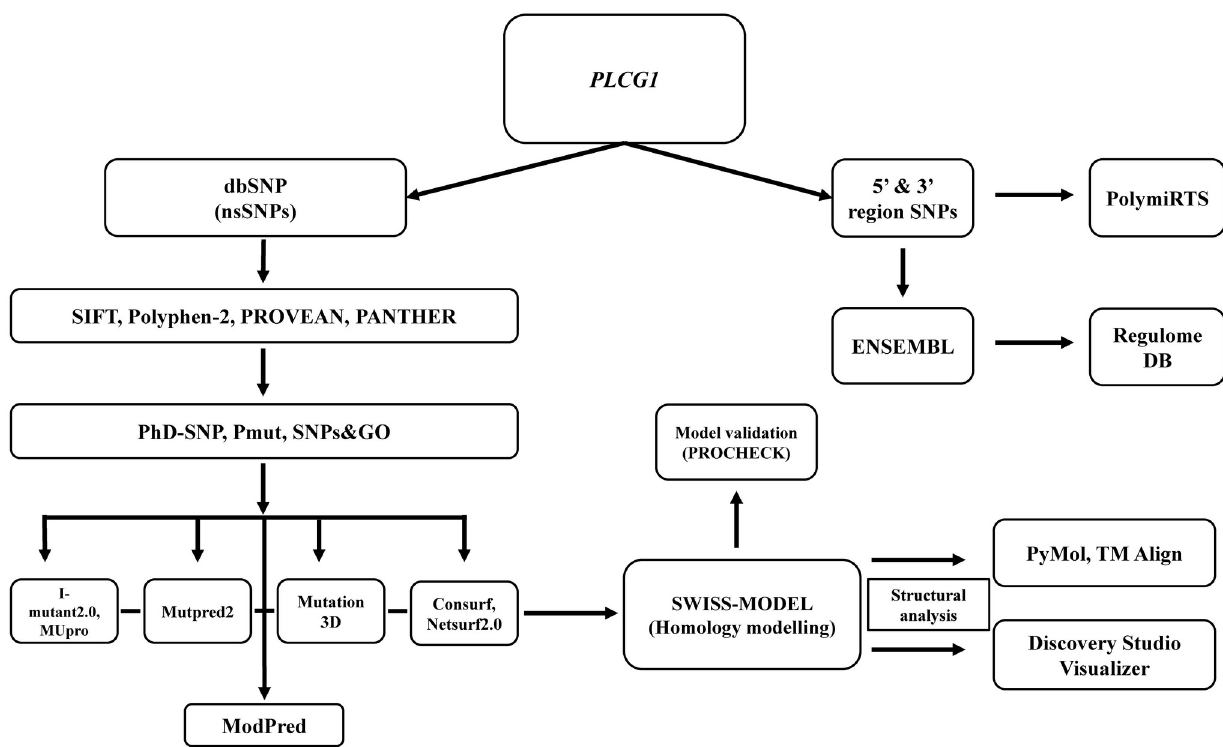
Fig 1. An outline of the methodology used in this